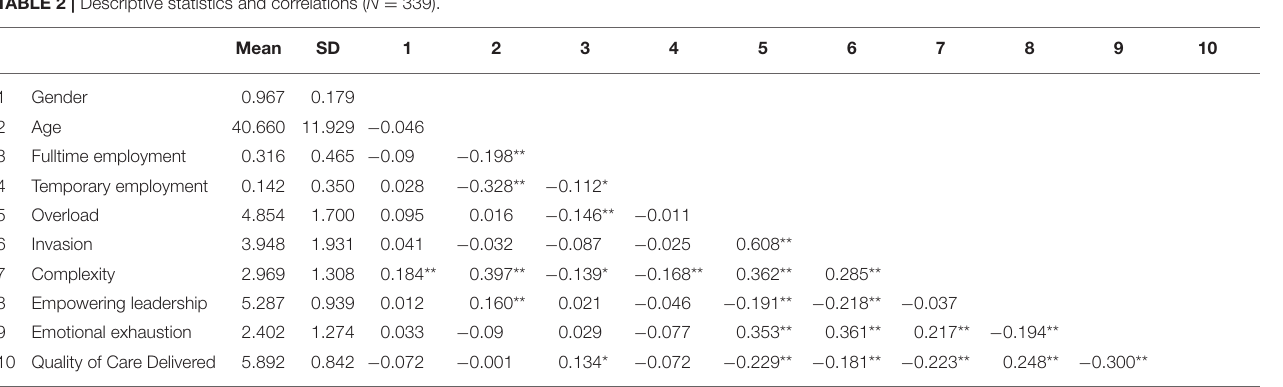
TABLE 2 | Descriptive statistics and correlations ( N =